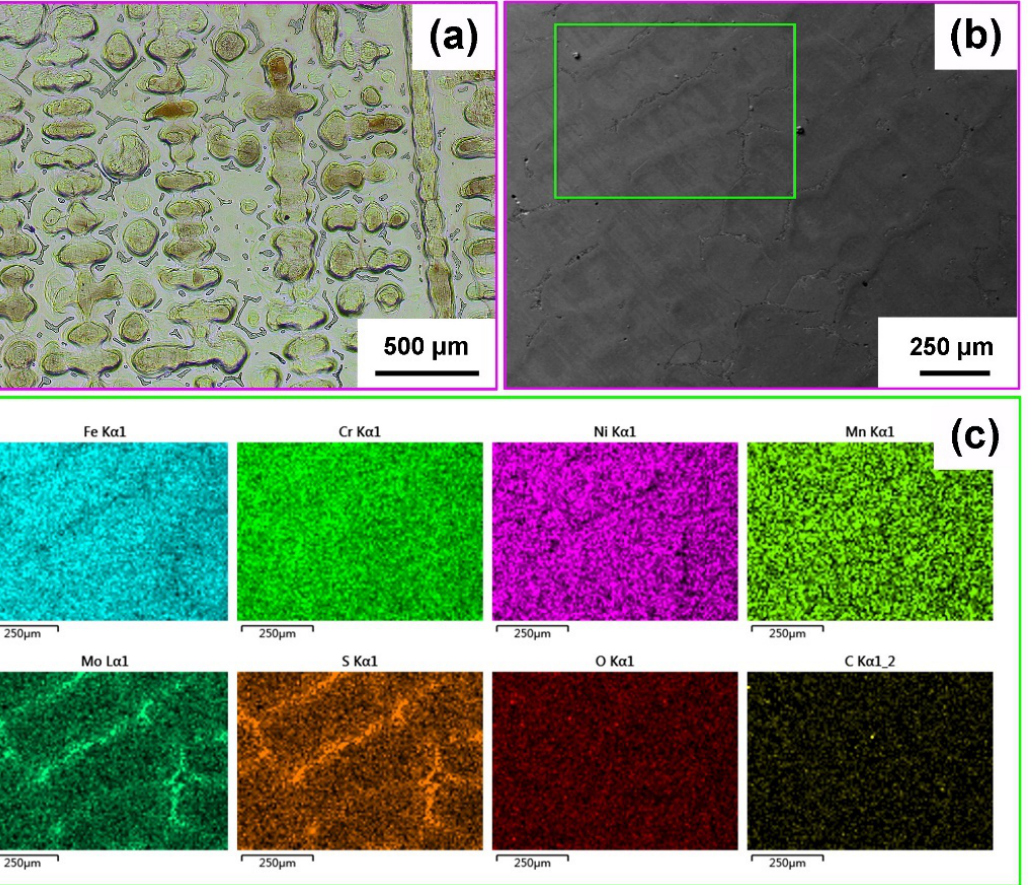
Figure 1. The element segregation analysis results, ( a ) metallographic microstructure of the as-cast S31254 SASS, ( b ) the position of the surface scan analysis in the SEM image of the as-cast microstructure, ( c ) the results of surface scanning analysis.